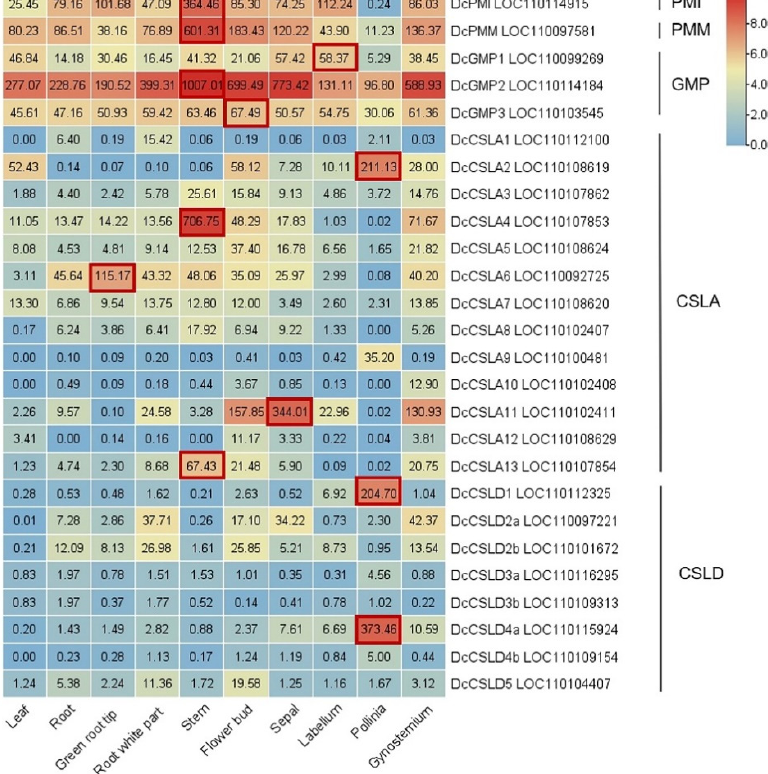
Figure 5. Expression profile of glucomannan pathway genes in tissues and organs of D. catenatum . The raw RNA-seq reads of different tissues and organs in D. catenatum are derived from the NCBI database (www.ncbi.nlm.nih.gov), including the leaf (SRR4431601), the root (SRR5722140), the green root tip (SRR4431599), the white part of the root (SRR4431598), the stem (SRR4431600), the flower bud (SRR4431603), the sepal (SRR4431597), the labellum (SRR4431602), the pollinia (SRR5722145), and the gynostemium (SRR4431596). A heatmap has been generated via TBtools software [89]. The color scale represents log2 of FPKM expression values; green and red indicate a low and high level of gene expression, respectively.